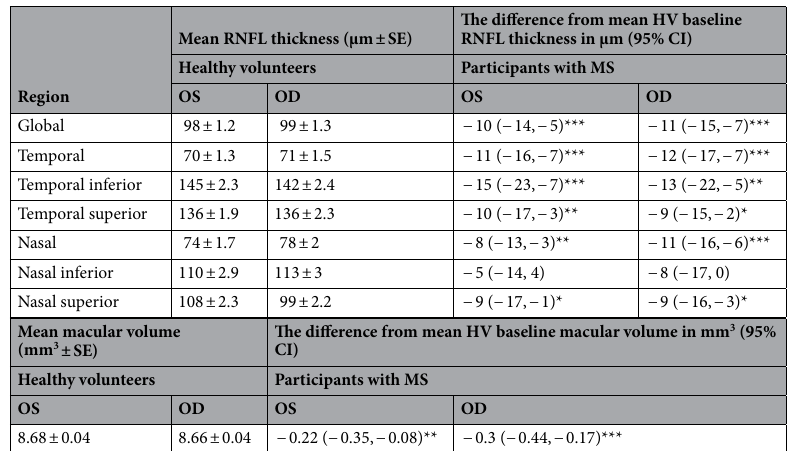
Table 2. Baseline OCT data. The differences in mean baseline RNFL thickness and macular volume for MS participants when compared to healthy volunteers (HV), assessed using an unpaired samples Student’s t-test. SE, Standard error; CI, Confidence interval; OS, Left eye; OD, Right eye. * p < 0.05; ** p < 0.01; ***p < 0.001.